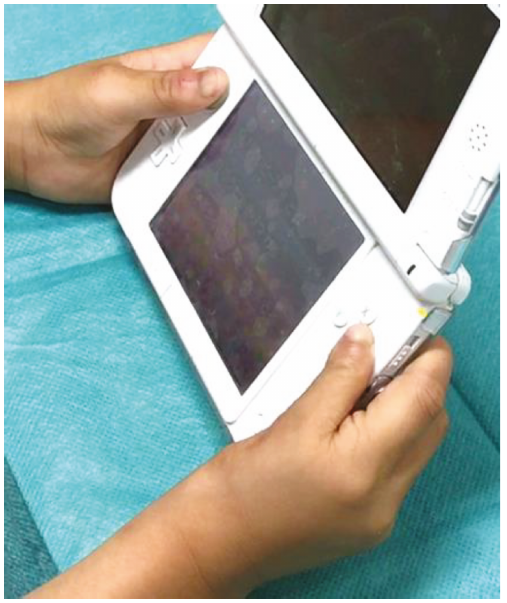
Figure 7: He can push the buttons on a portable game